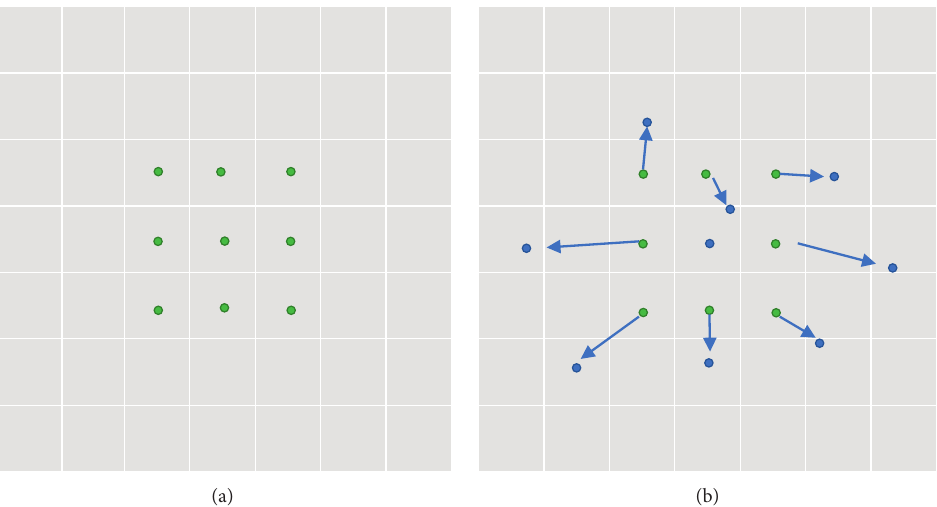
Figure 2: All examples use a 3 × 3 convolutional kernel. (a) Standard convolution: green dots are the sampling points. (b) Deformable convolution sampling locations (dark blue points) with augmented offsets (light blue arrows) in the deformable convolution.